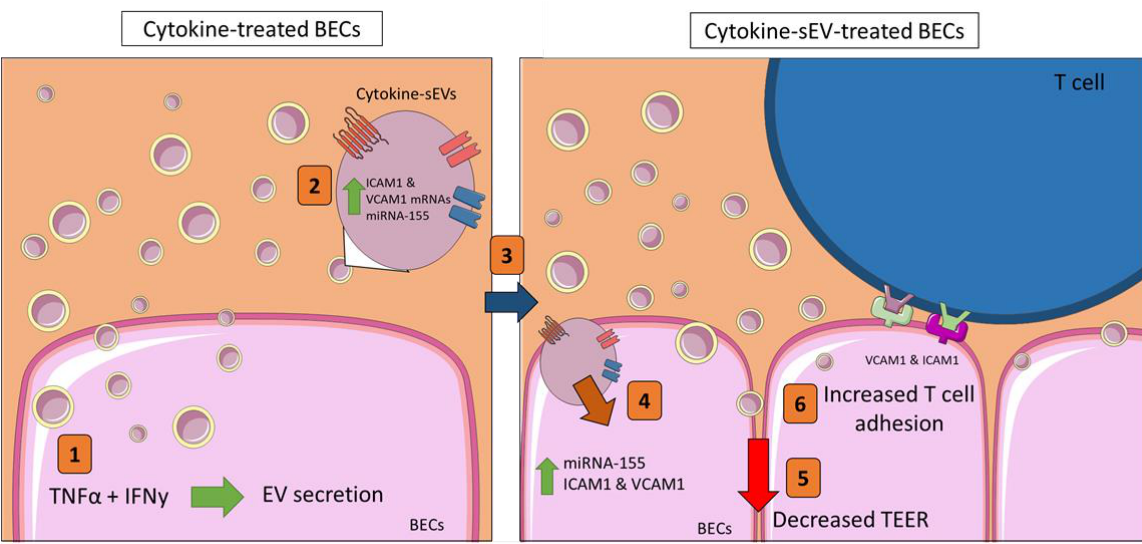
Figure 7. The proposed model for the cytokine-sEV role in modulating cerebrovascular functions. (1) The incubation of hCMEC/D3 cells with 10 ng/mL of TNFα and IFNy increased the secretion of small EVs (cytokine-sEVs). (2) These cytokine-sEVs carried elevated levels of the proinflammatory miRNA-155 , as well as mRNAs of VCAM1 and ICAM1 . (3) Naïve hCMEC/D3 cells take up cytokine-sEVs, leading to increased intracellular levels of miRNA-155 and ICAM1 and VCAM1 in recipient hCMEC/D3 cells (4). Consequently, the endothelial resistance is decreased (5), while the firm adhesion of Jurkat T cells (6) is increased in recipient endothelial cells.